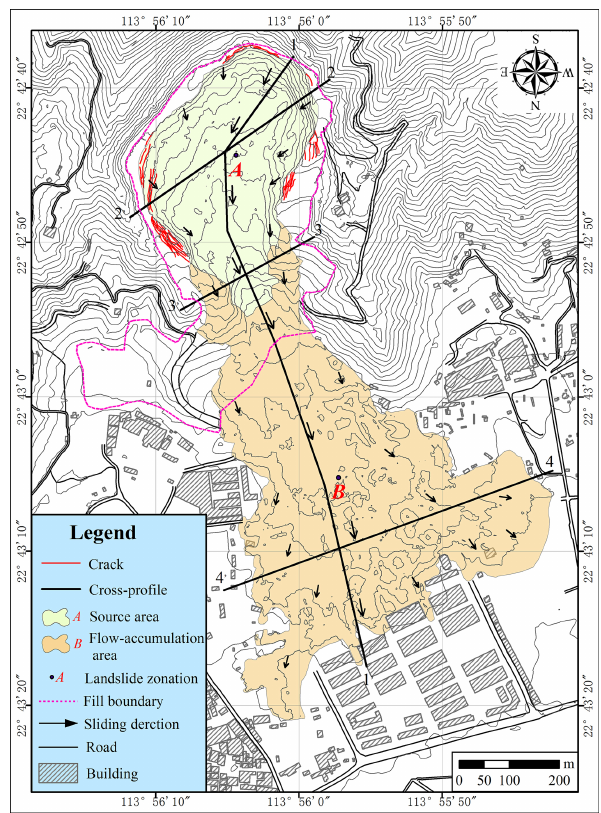
Figure 9. The topographic map of the